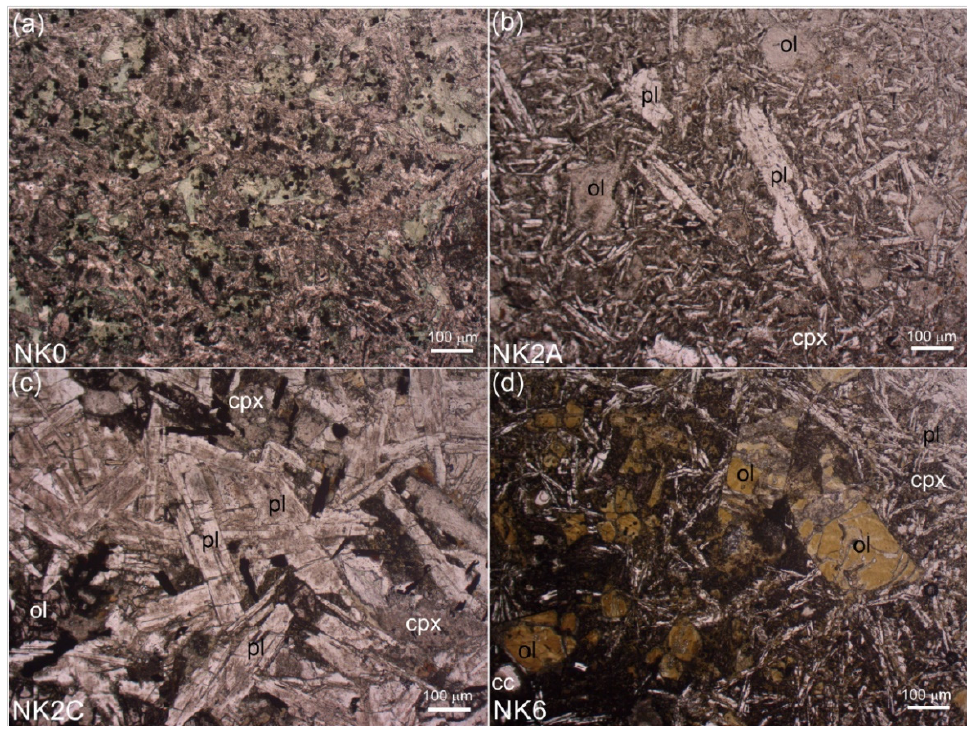
Figure 4. Main petrographic features of the Njimom dykes. ( a ) Altered aphyric basalt NK0; ( b ) sub- ophitic texture in basalt NK2A. The olivine phenocrysts are completely altered; ( c ) intergranular texture in aphyric basalt NK2C with plagioclase, altered olivine, clinopyroxene and opaque oxides; ( d ) porphyric texture in basalt NK6. The olivine is completely iddingsitized. The dykes in ( a – c ) cross-cut the mylonitic gneiss. The dyke NK6 intrudes ( d ) the granitic basement. Mineral names are abbreviated as cpx clinopyroxene; pl, plagioclase; ol, olivine; cc, calcite.